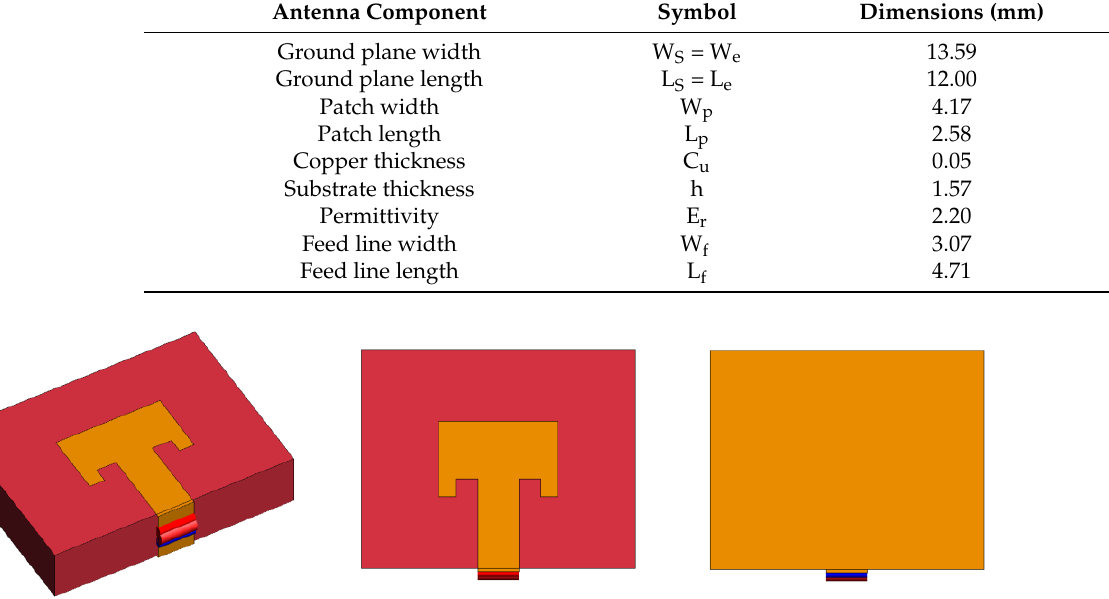
Figure 2. Antenna model view, front and back